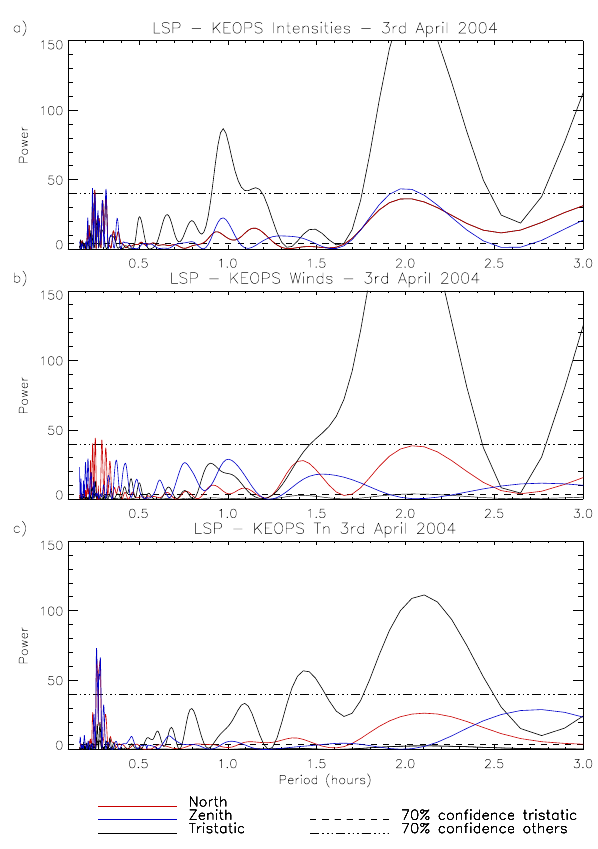
Fig. 6. Lomb-Scargle Periodogram of FPI data from KEOPS on 3 April 2004: (a) intensities, (b) winds, and (c) temperatures. The low resolution look directions are scaled by a factor of ten for com-